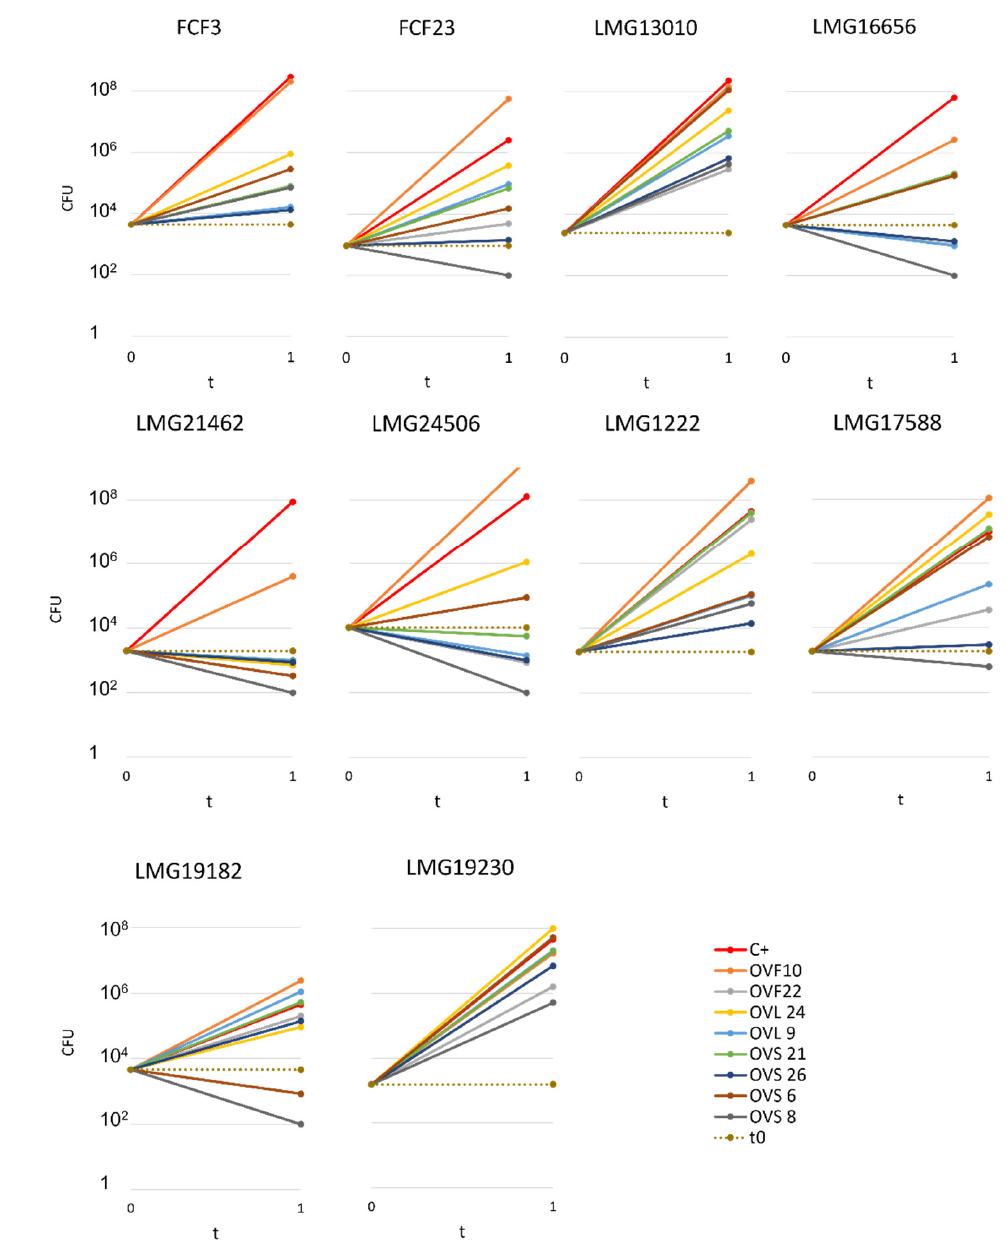
Figure 3. O. vulgare ssp. vulgare endophytes’ VOC effect on target strains’ growth